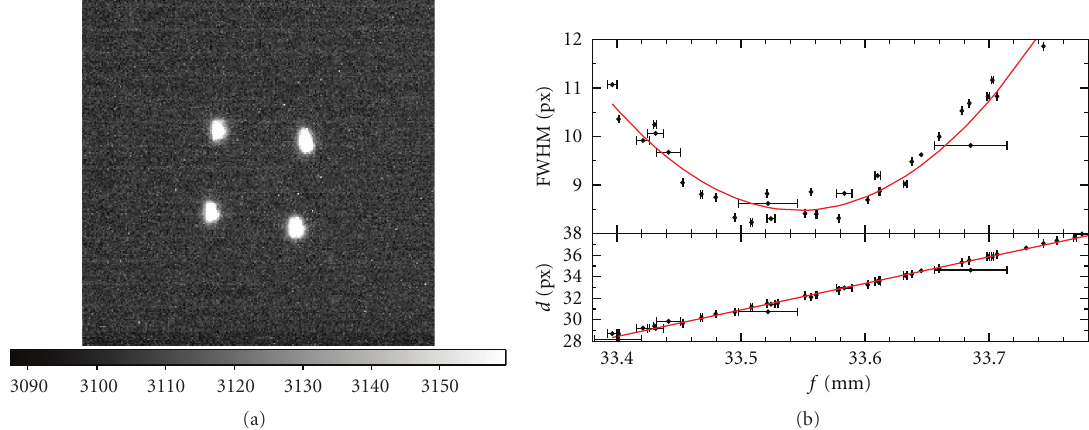
Figure 5: (a) The image of a single star with the focus pyramid introduced into the beam. Possible errors in the center-of-gravity determination of the four image centers do not hamper the focussing accuracy due to the high sensitivity of the subimages’ distances on the focus position. (b) The calibration curve used to convert the pyramid’s subimage distances to the focus applied. (a) shows the measured FWHM of a star without the pyramid in the optical beam as a function of focus position (distance of the secondary mirror to M1). (b) shows the average distance of the four subimages in pixel with the pyramid inside the optical beam. This calibration has been done at a very early time in the commissioning of the telescope, when the telescope control system was still unstable in attaining certain focus positions. This is visible as the sometimes huge error bars in the focus position.